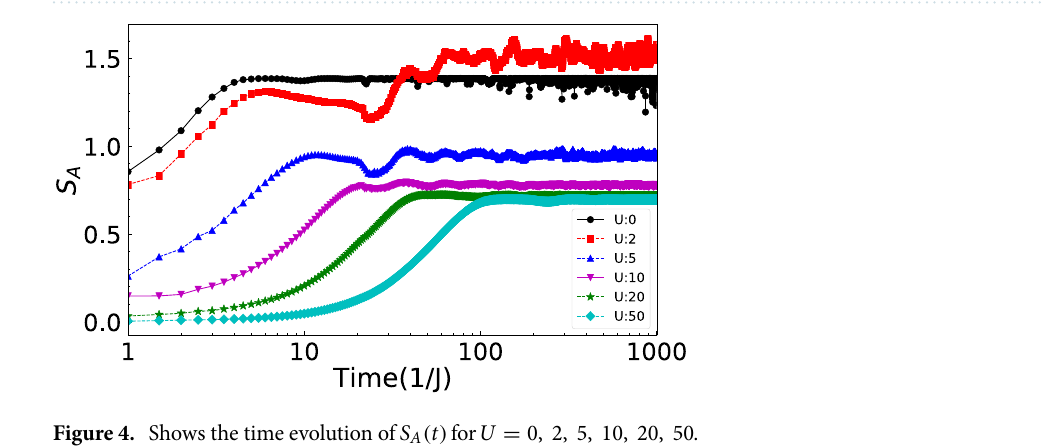
Figure 3. ( a ) R ( t ) and ( b ) v ( t ) are plotted for U = 0, 2 and 10 corresponding to the expansion of the wave function of ↑ particle when δ = 0.2 .